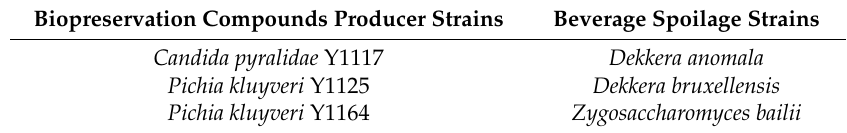
Table 1. Biopreservation compounds producers and beverage spoilage yeasts selected for the current